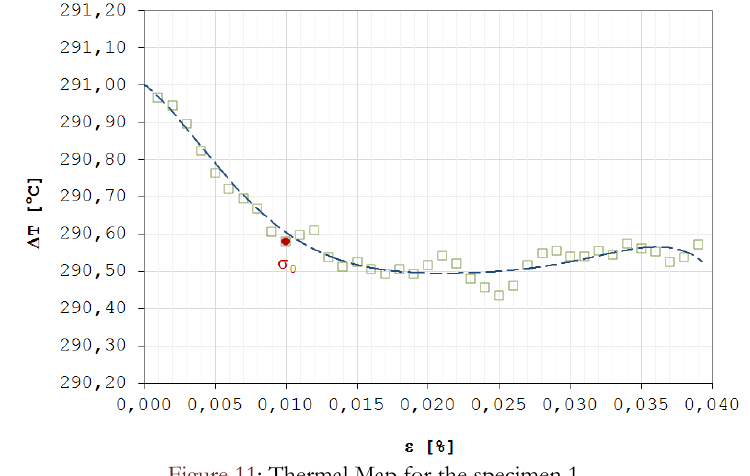
Figure 11: Thermal Map for the specimen 1.